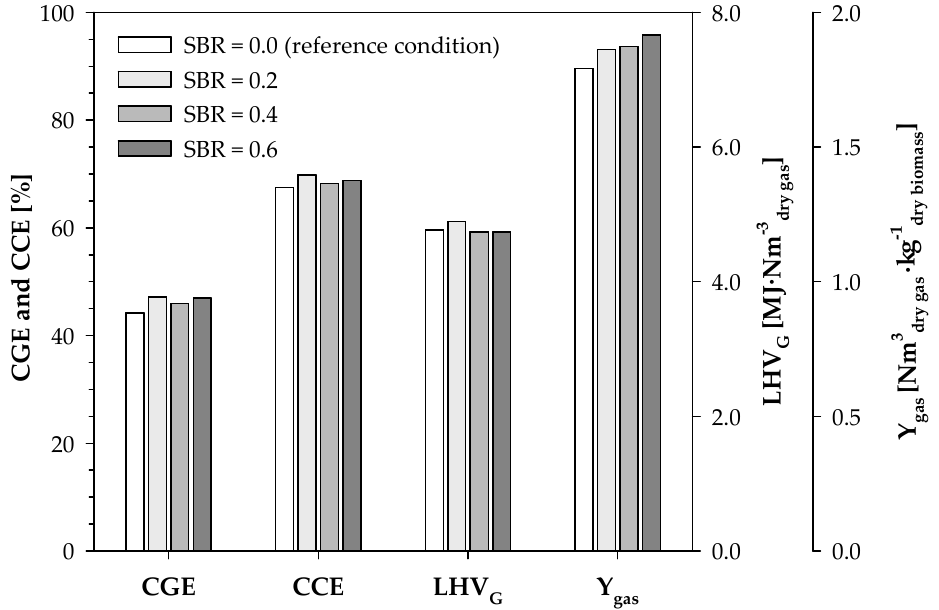
Figure 4. Effect of steam addition on the LHV G and performance parameters during air gasification of RFB from eucalyptus ( φ = 20 %vol. O ₂ , dry GA —Tables 3 and 4).